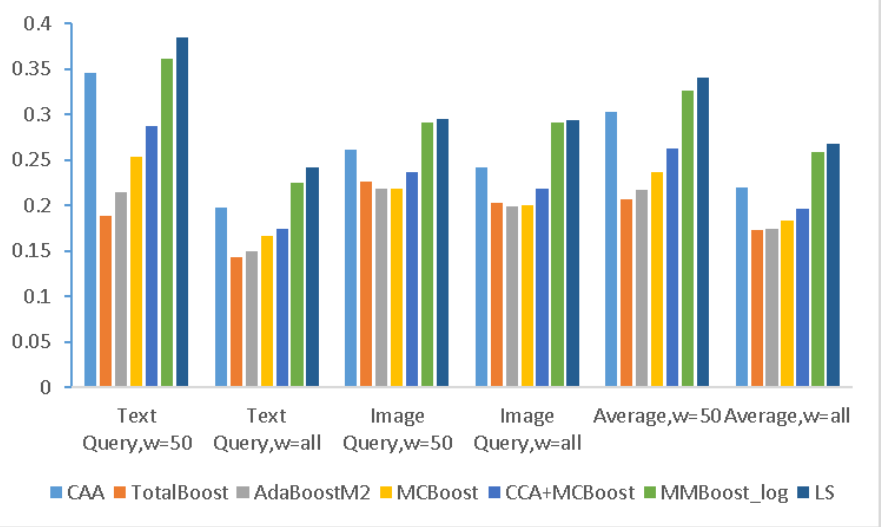
Figure 4. Performance comparison on the Wiki